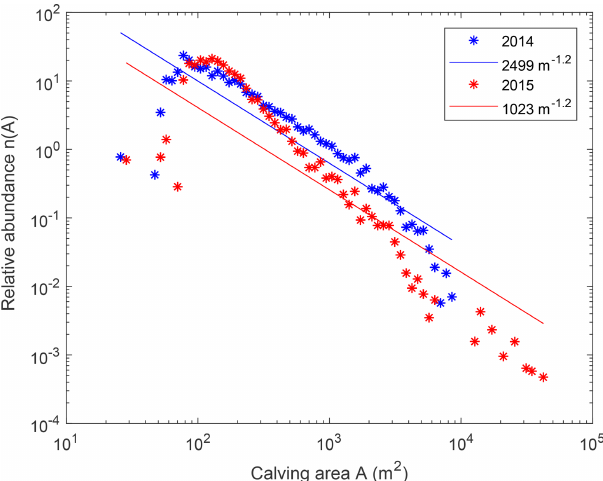
Figure 13. Relative abundance distribution n(A) of calving areas A for 2014 (blue stars) and 2015 (red stars). The plain curves are power-law estimates of exponent − 1 . 2 for 2014 (blue) and 2015